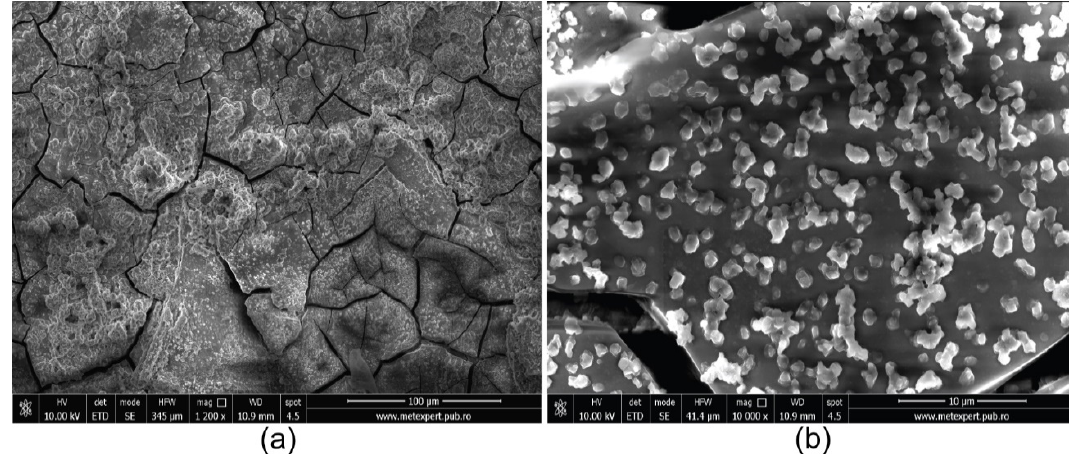
Figure 2. SEM morphology of the CoCrFeMnNi film electrodeposited at −2.5 V for 30 min: ( a ) ×1200; ( b ) ×10000.